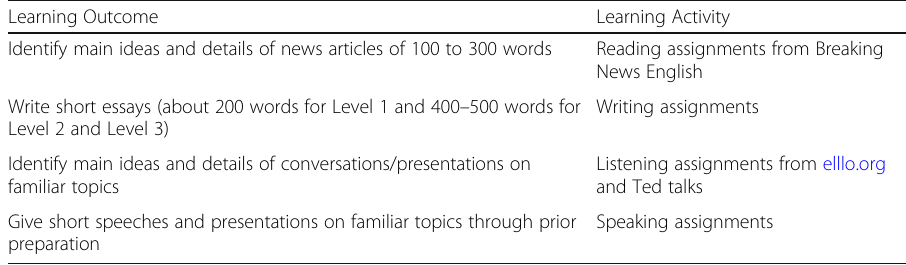
Table 2 Connection Between Learning Outcomes and Learning Activities in OUGEO Learning Outcome Learning